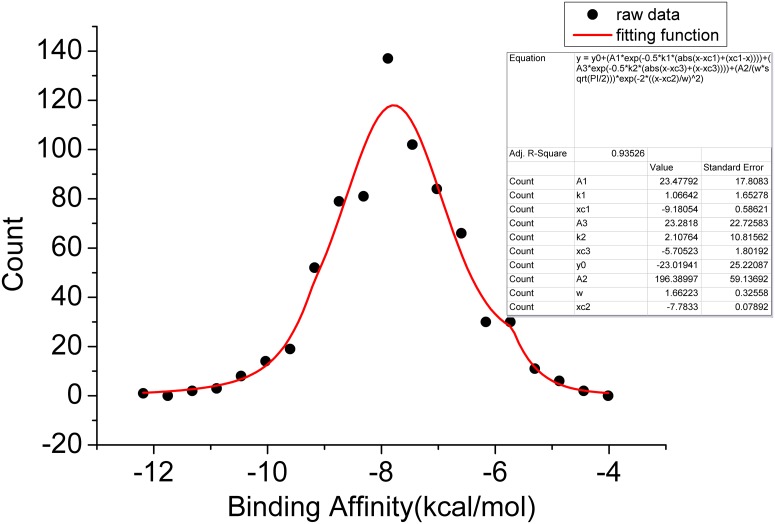
The distribution of the free energy with 720 compounds binding to the Cox2.the vertical axis represents the number of states or probability for the free energy, gaussian curve: in the center; exponential curve: near the tail. The parameter values for these distributions are presented. The analytical function consisting of a Gaussian and two exponential functions is highlighted with red line.